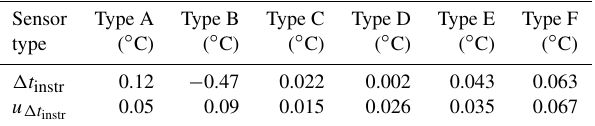
Table 3. Results of the evaluation of (cid:49)t instr and the associated un- certainties u (cid:49)t for each instrument instr